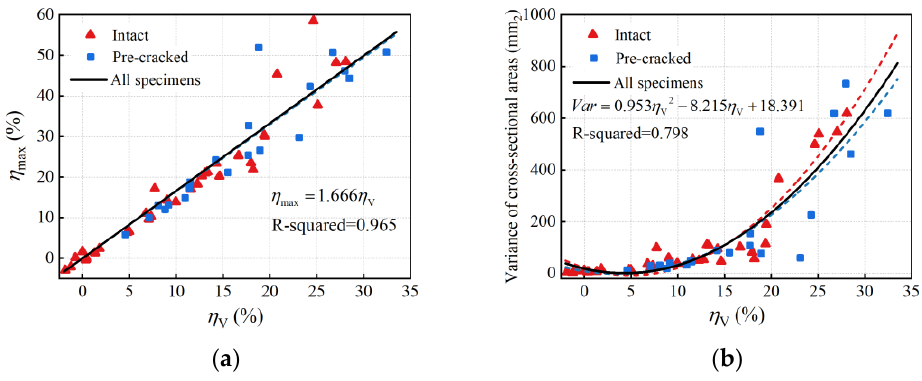
Figure 6. Non-uniform corrosion parameters: ( a ) maximum cross-section loss; ( b ) variance in cross-sectional areas.